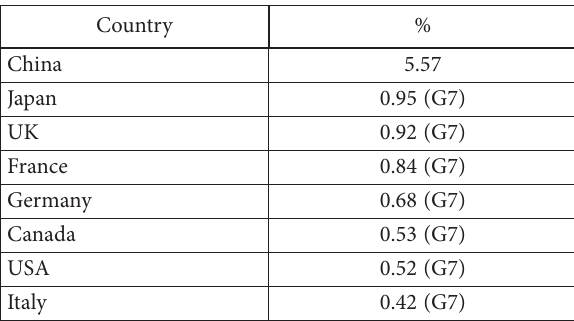
Table 4. Global investments on the construction and maintenance of infrastructure as share of GDP in 2019 by country (source: Statista, 2021) Country